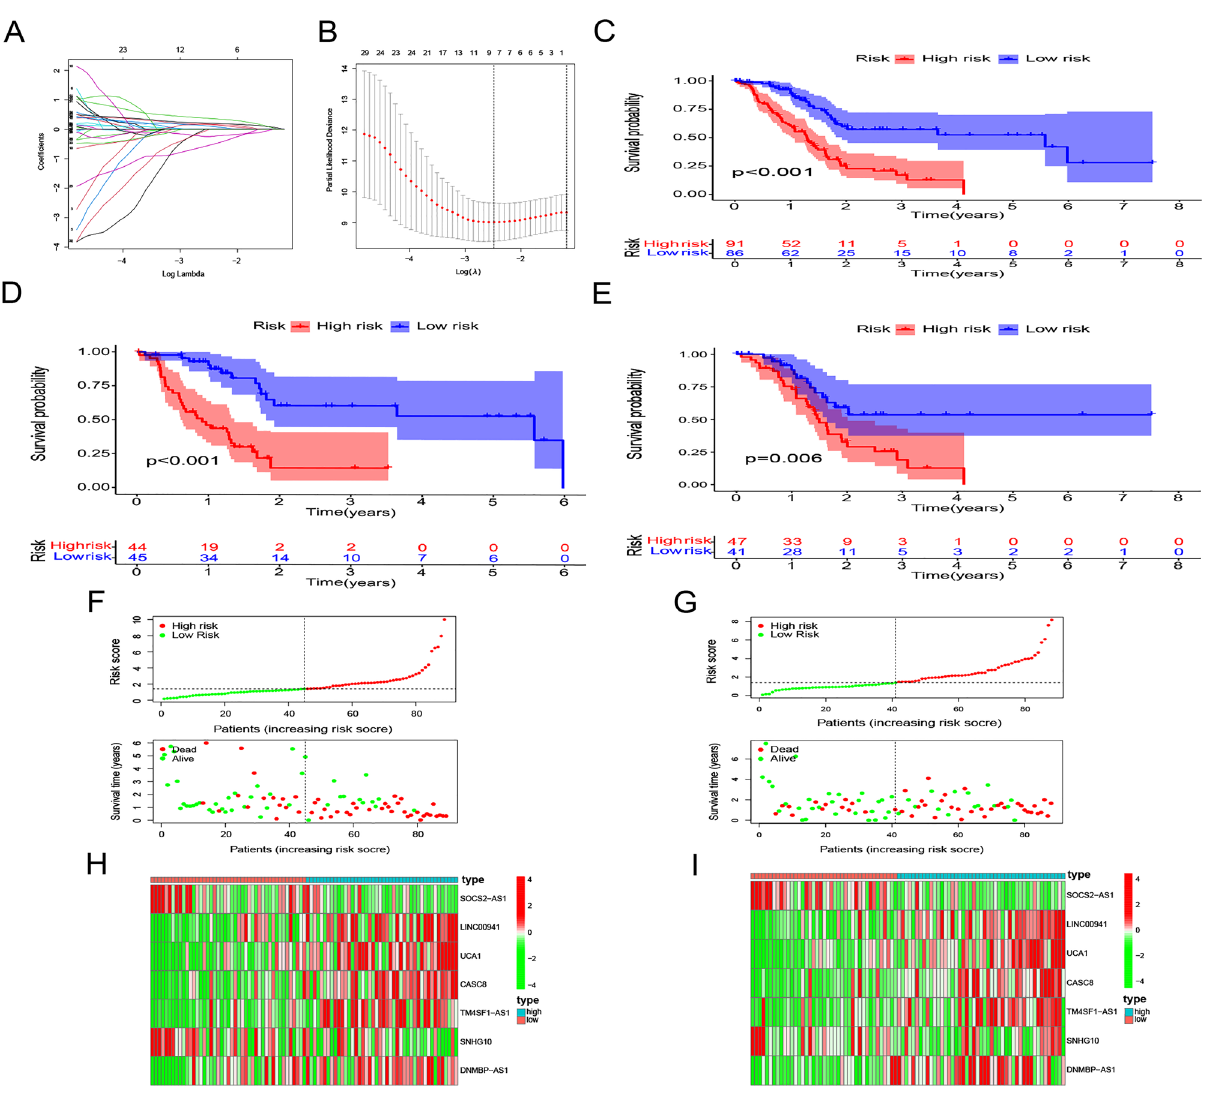
Figure 4. Models of m6A/m5C/m1A-related lncRNAs as pancreatic cancer markers. ( A , B ) Prognostic models for m6A/m5C/m1A-related lncRNAs were constructed using least absolute shrinkage and selection operator regression. ( C – E ) Kaplan–Meier survival curves between the high- and low-risk groups in the complete dataset, training set, and validation set. ( F , G ) Plots of risk score and survival status distribution in the training and validation sets. ( H , I ) Heatmaps of the seven lncRNAs in the training and validation sets.